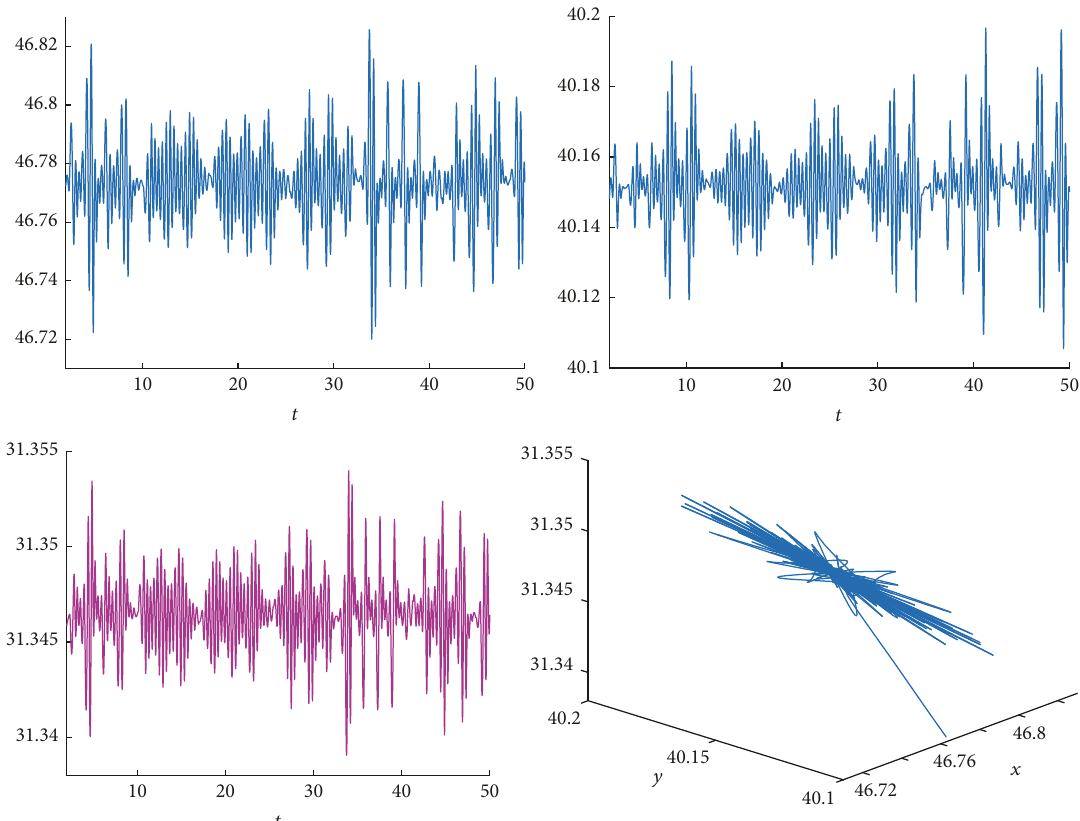
Figure 4: Dynamical behaviors and phase space trajectories of the three fish